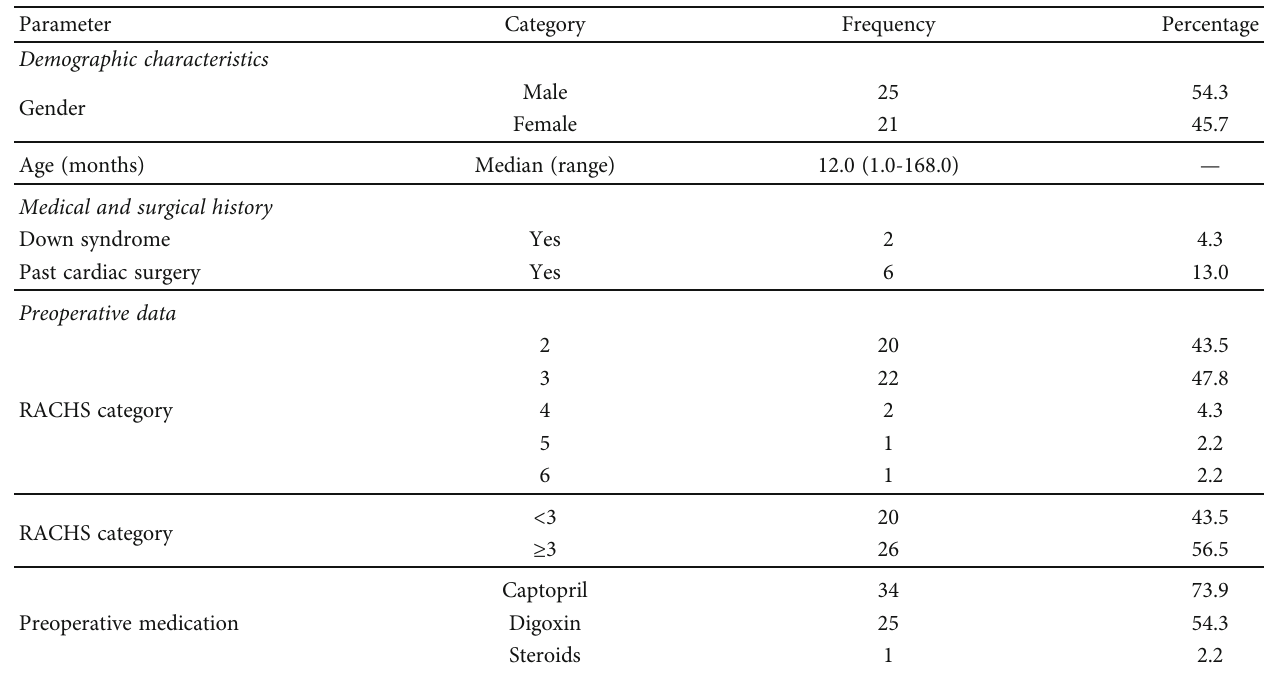
Table 1: Participants ’ demographic and preoperative characteristics ( N = 46